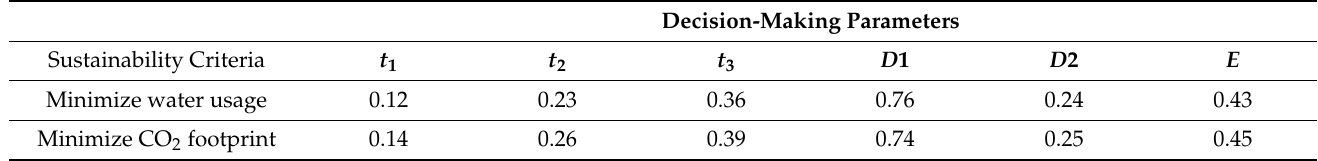
Table 8. Sustainability reassessment of wooden materials.